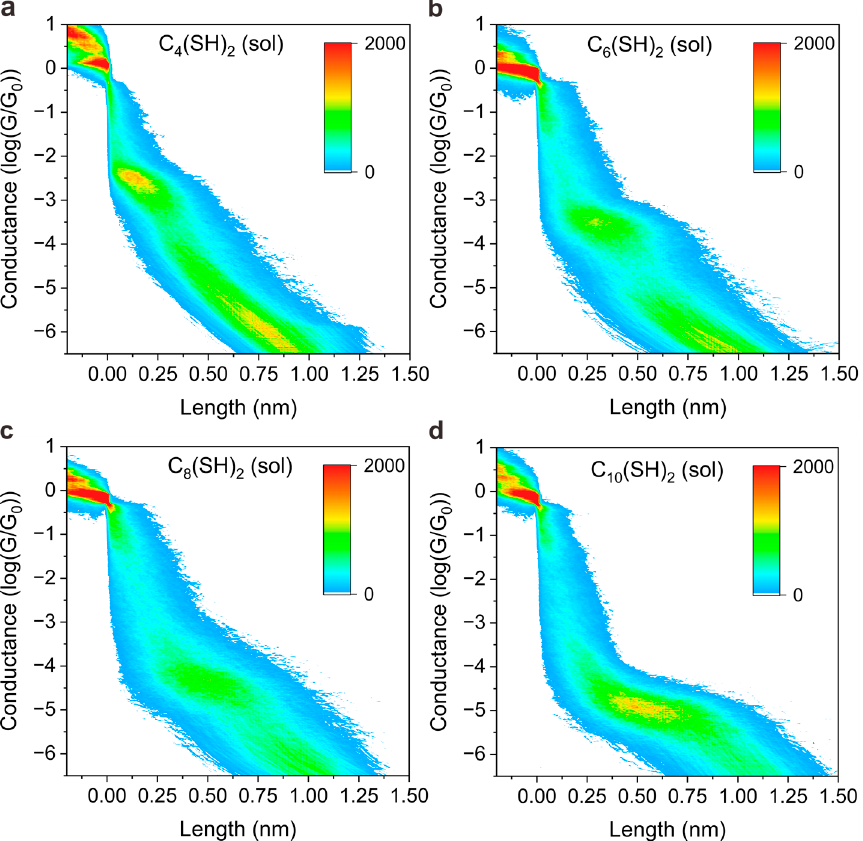
Figure 4. Experimental results of single-molecule conductance measurements in solutions. The 2D conductance–distance histograms for C 4 (SH) 2 ( a ), C 6 (SH) 2 ( b ), C 8 (SH) 2 ( c ), and C 10 (SH) 2 ( d ) were measured without laser illumination.